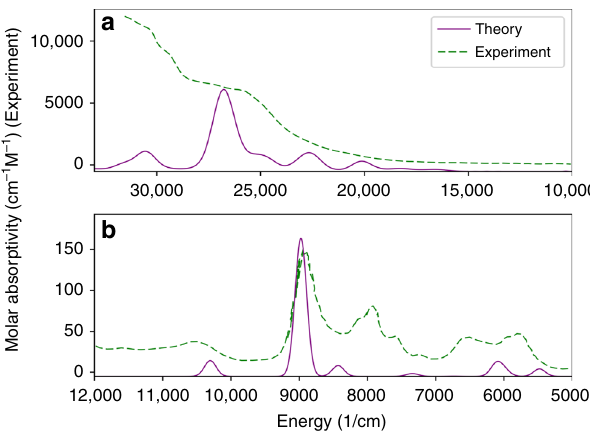
Fig. 7 UV-Visible-NIR electron absorption spectra for (C 5 Me 5 ) 2 U[ η 4 - 1,2,3,4-PhC 4 Ph]. Experimental values (dashed lines) digitized from ref. 32 . a UV-Visible range. b Near IR range. Peaks at 8,936 cm – 1 and 20,625 cm – 1 with oscillator strengths of 0.0102 and 0.0387, respectively, are derived from transitions involving the φ bonding